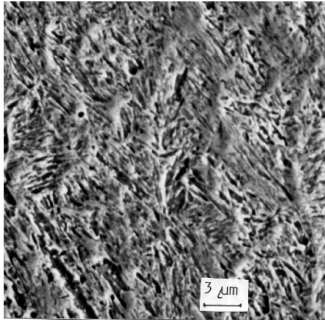
Figure 8. Carbidic phase in bainitic matrix of the weld E 508